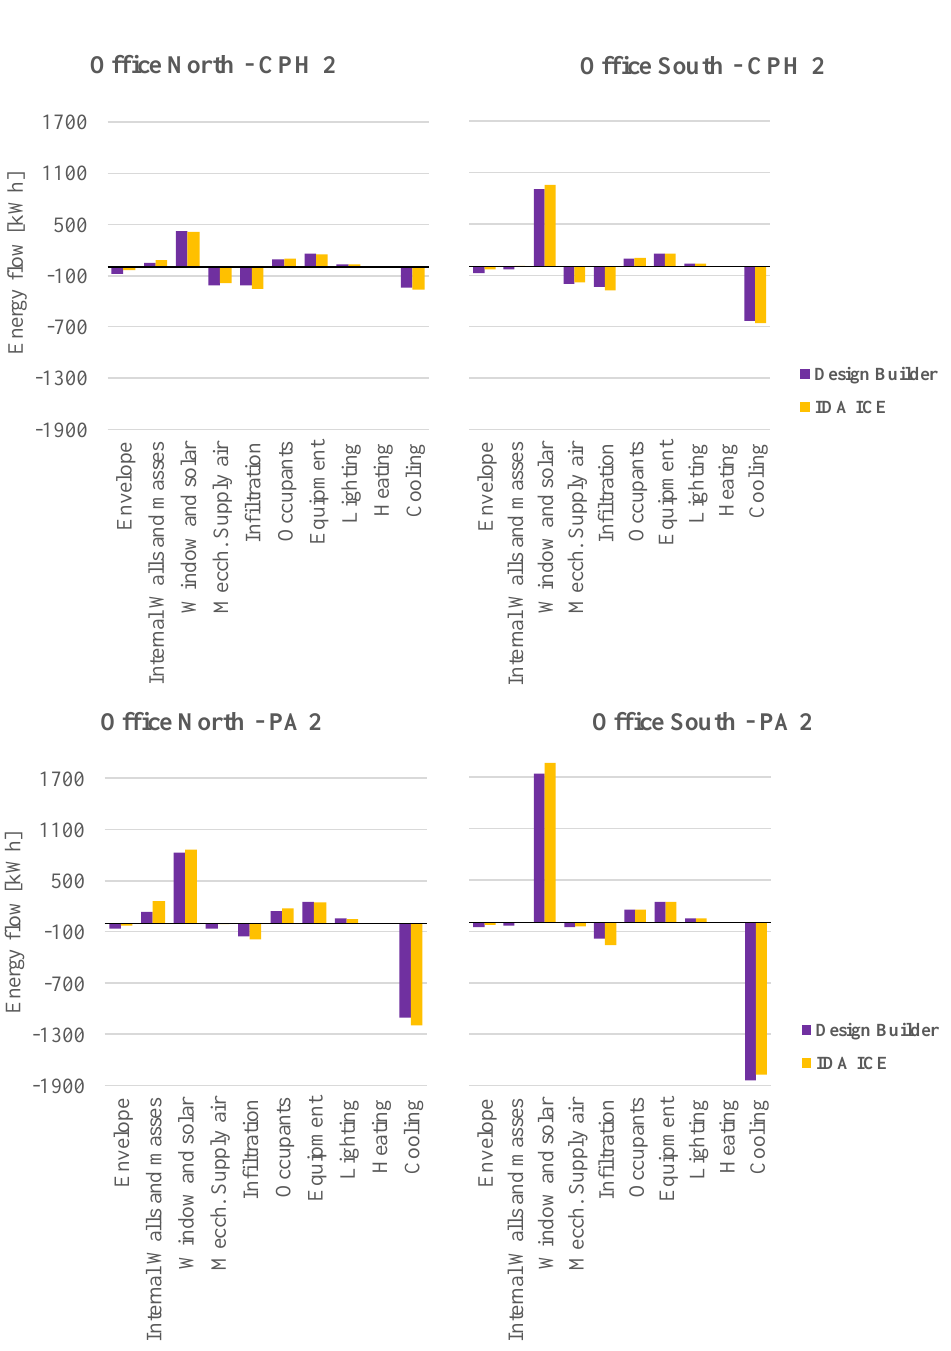
Figure 10. Energy flows for Copenhagen (up) and Palermo (down) in scenario 2 during the cooling season.